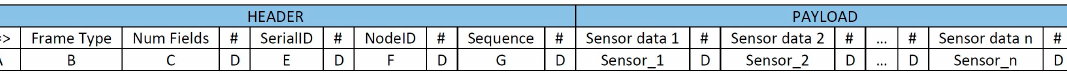
Figure 4. ASCII frame structure employed in the mobile node.